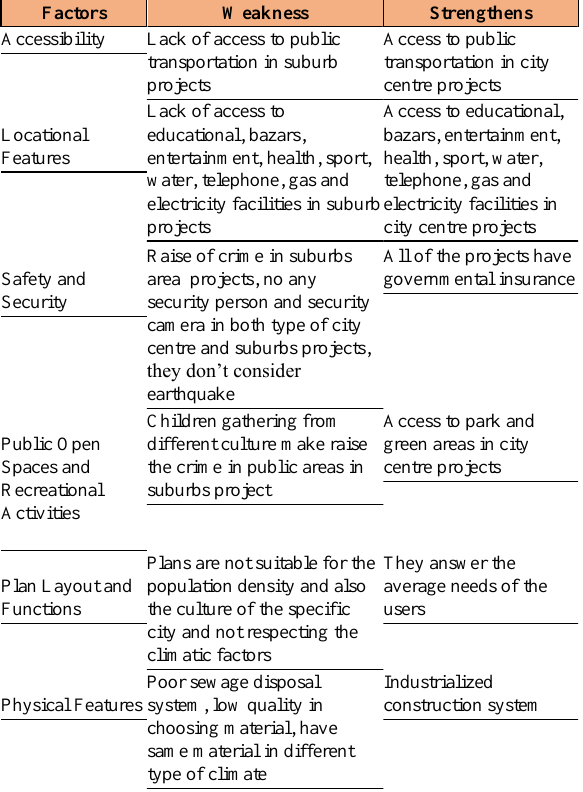
Figure 8 : Mehr housing project in Semnan city (author) Table 2 : General weaknesses and strengthens of Mehr